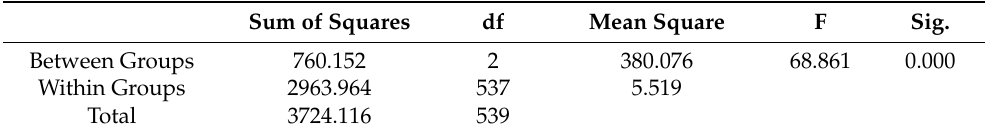
Table 2. Multiple comparison test between conventional, milled and printed groups. Sum of Squares df Mean Square F Sig. Between Groups 760.152 2 380.076 68.861 0.000 Within Groups 2963.964 537 5.519 Total 3724.116 539